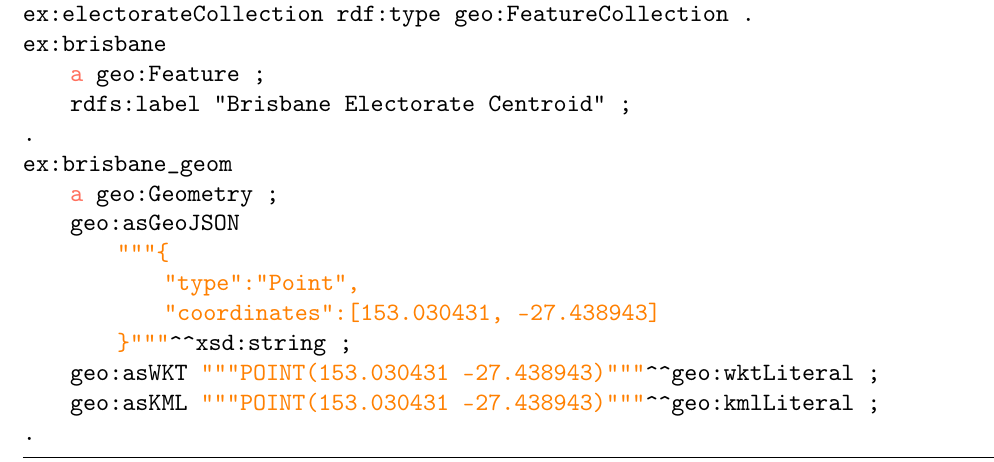
Listing 11. SHACL shape validation case: A geometry with a wrong literal type, two serializations, a missing connection to its corresponding feature and a non-connected